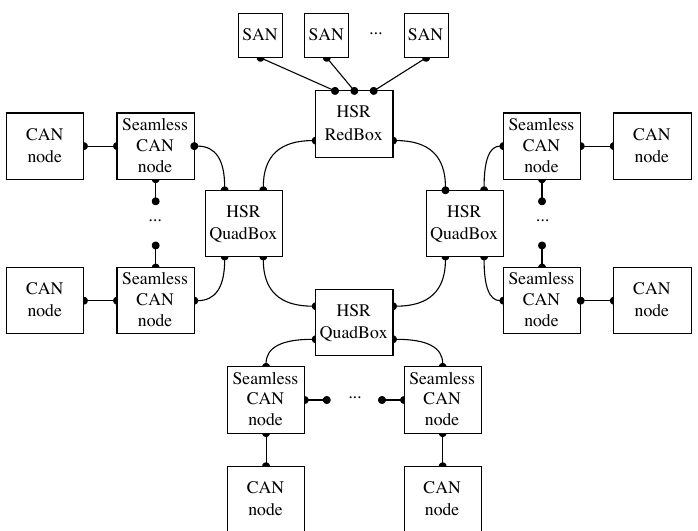
Figure 6. Example of an enhanced seamless CAN-based in-vehicle